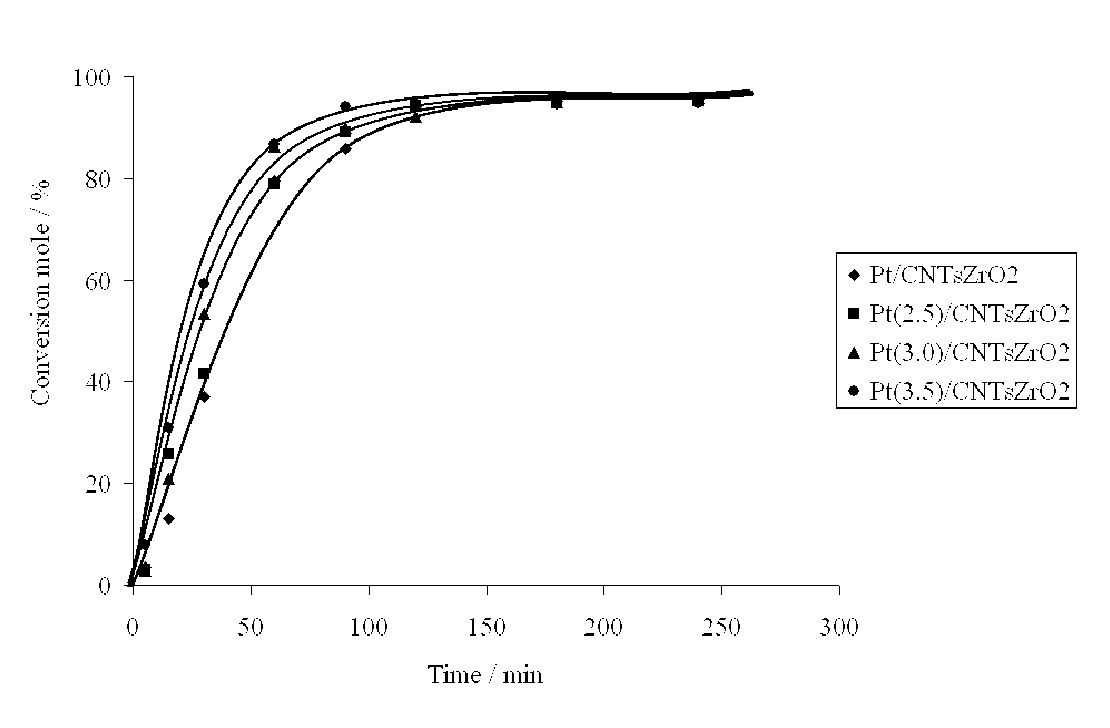
Figure 4. Evolution of the conversion level with time during 1-phenyl-1,2-propanodione hydrogenation on Pt/CNTsZrO 2